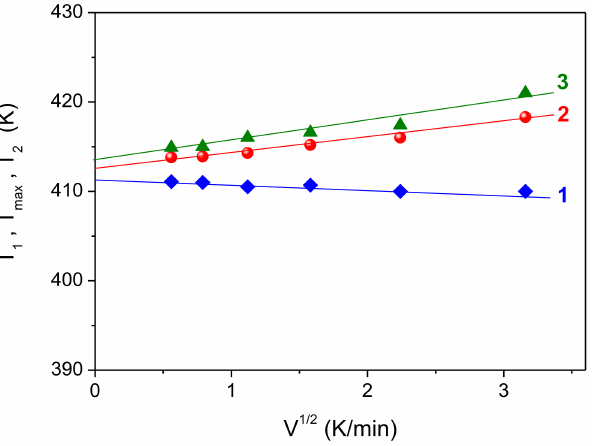
Figure 3. Dependences of temperature parameters T 1 ( 1 ), T max ( 2 ) and T 2 ( 3 ) of the melting peak of UHMWPE nascent powder samples of the same mass (6 mg) on the heating rate V 1/2